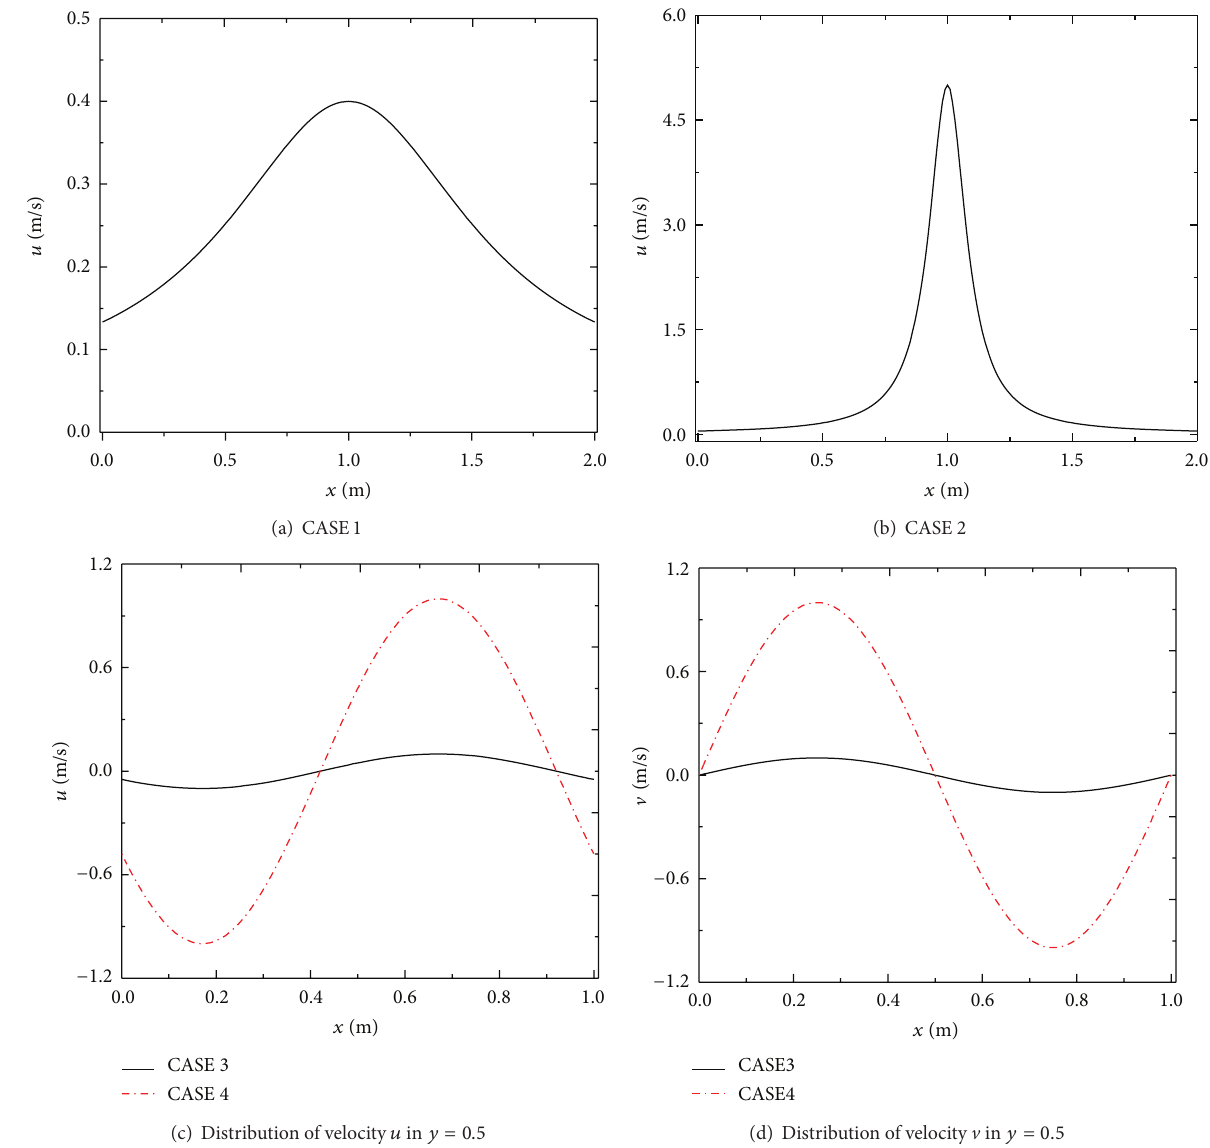
Figure 3: Velocity distribution along the 𝑥